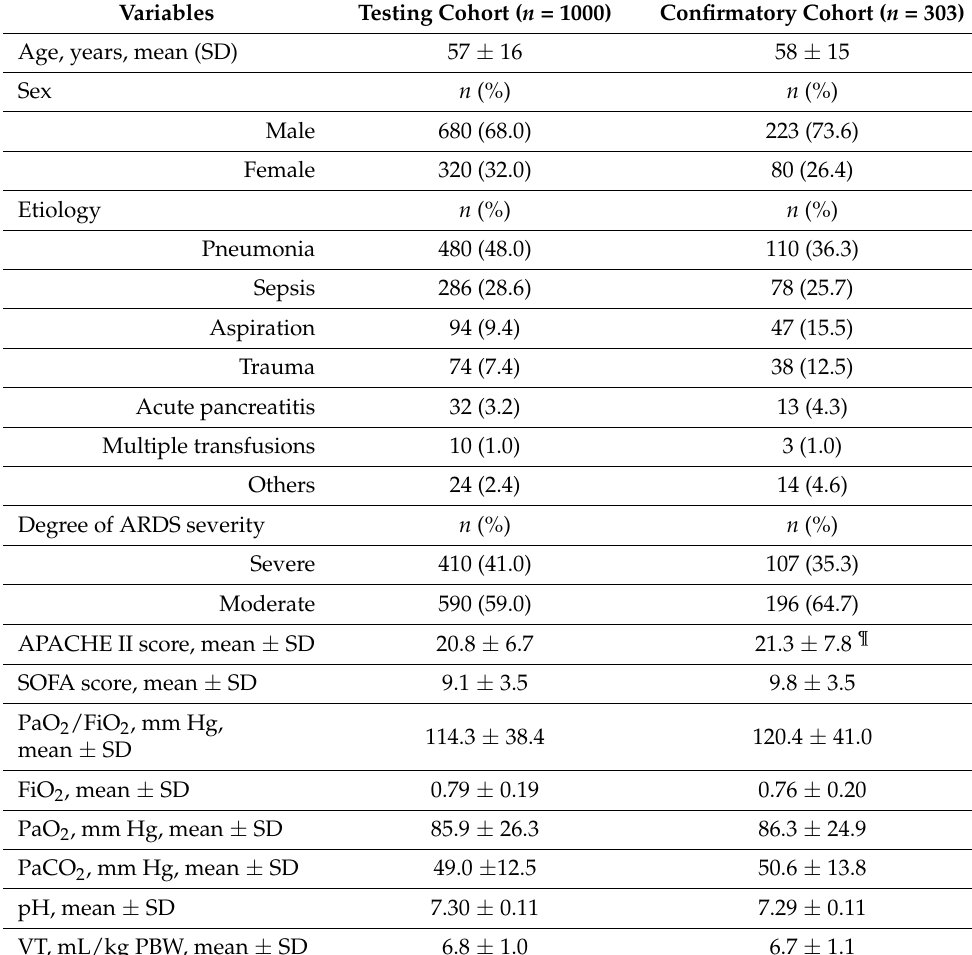
Table 1. Baseline characteristics and outcome data of 1303 patients with moderate to severe acute respiratory distress syndrome